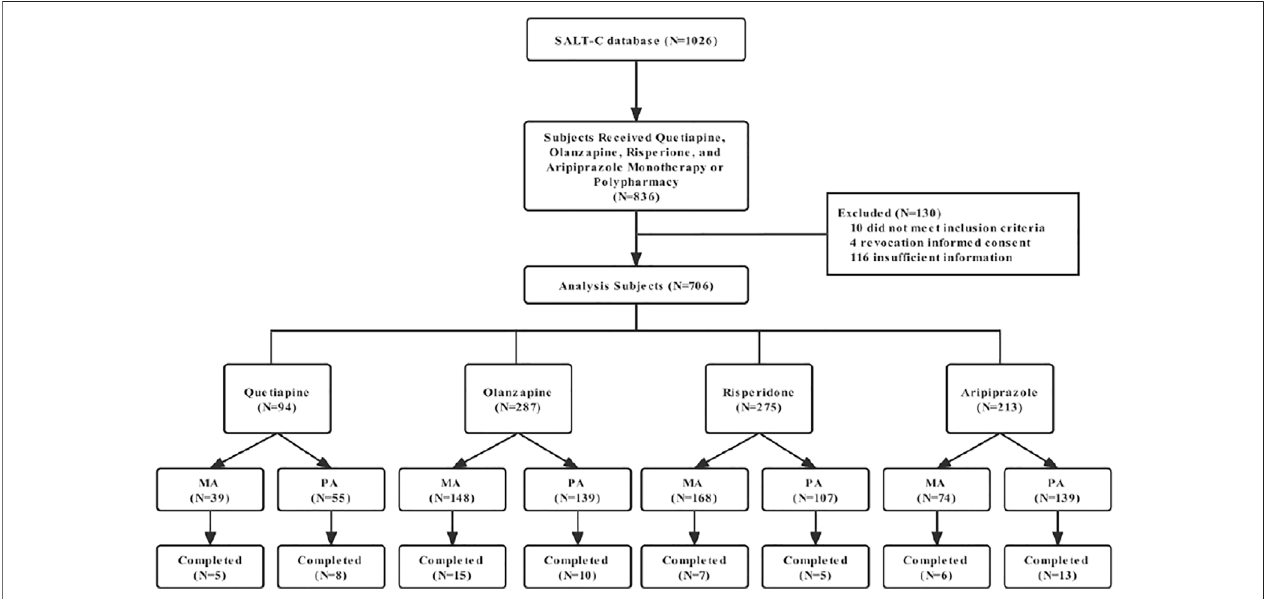
FIGURE 1 | Consort diagram showing fl ow of subjects in the